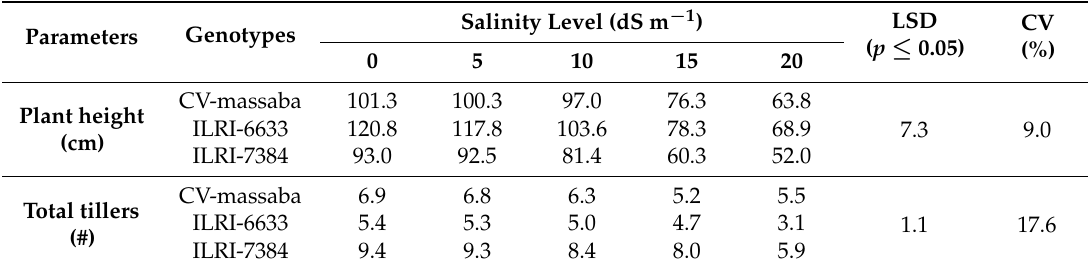
Table 1. Effect of different salinity levels on plant height and the number of tillers of three selected Chloris gayana genotypes.